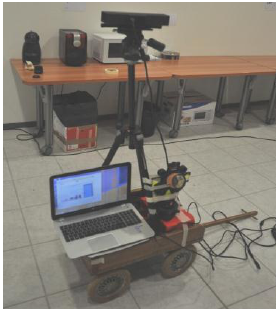
Figure 5. The Kinect installed together with the laptop and the reflective prism on the cart